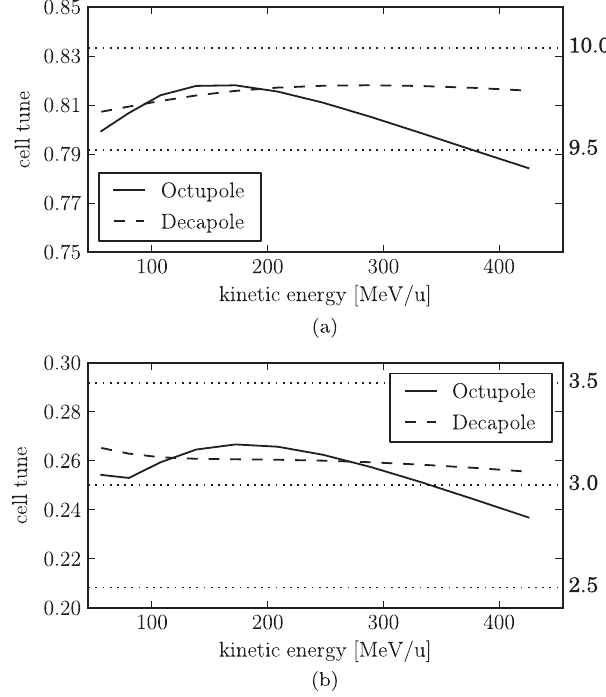
FIG. 11. Variation of horizontal cell tune (a) and vertical cell tune (b) for different orders of multipoles for the carbon ring. Dotted lines correspond to integer and half-integer resonances of the total machine tune.